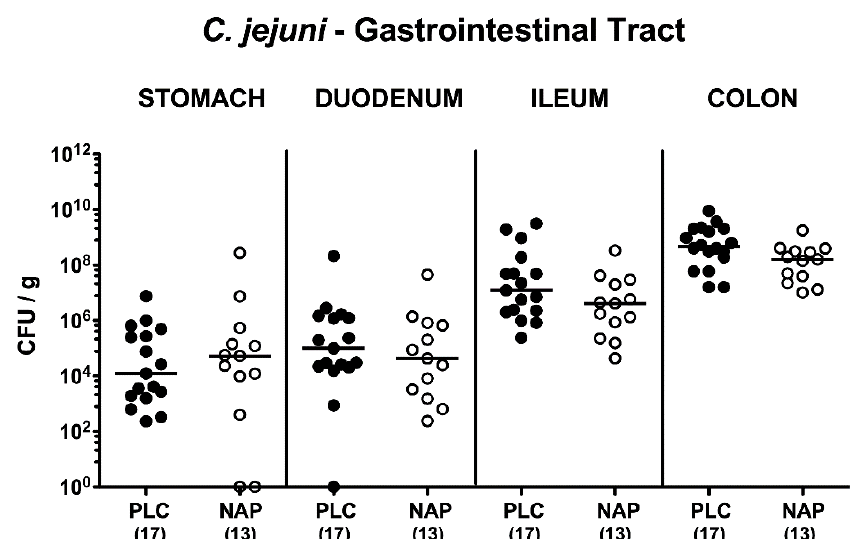
Figure 1. Gastrointestinal pathogen loads following NAP treatment of C. jejuni infected secondary abiotic IL10 − / − mice. On day (d) 0 and d1 secondary abiotic IL10 − / − mice were perorally infected with C. jejuni strain 81-176 by gavage and treated intraperitoneally with either synthetic NAP (open circles) or placebo (PLC; closed circles) from d2 until d5. Upon necropsy on day 6 post-infection, luminal bacterial loads were quantitatively assessed in distinct gastrointestinal compartments by culture (in colony forming units per g; CFU / g) as indicated. Medians (black bars) and numbers of analyzed animals (in parentheses) are given. Data were pooled from four independent experiments.